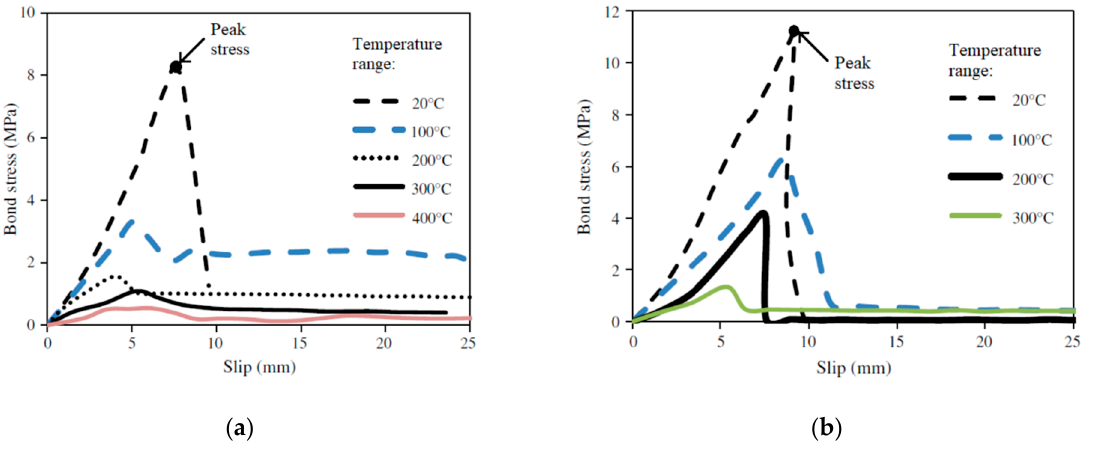
Figure 16. Bond stress–slip relations for NSM CFRP specimens with Tyfo 300 epoxy at different